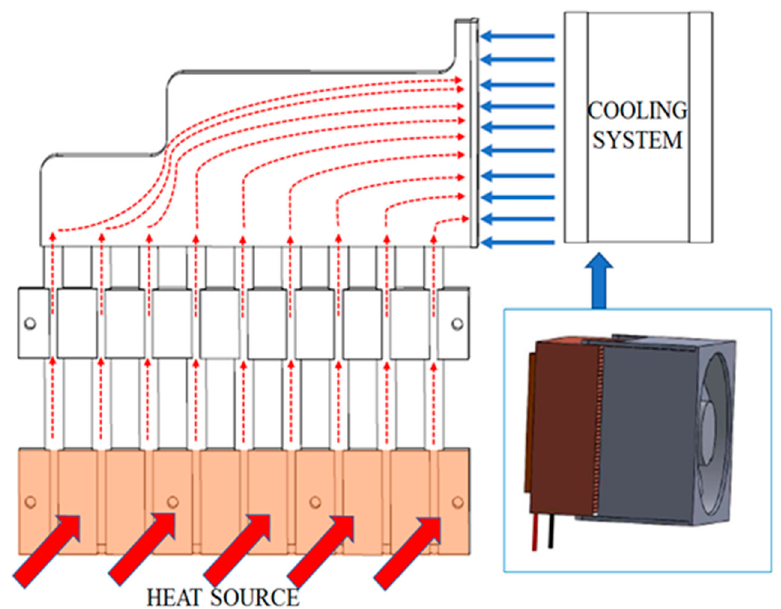
Figure 3. The Thermal Energy Transfer Path.